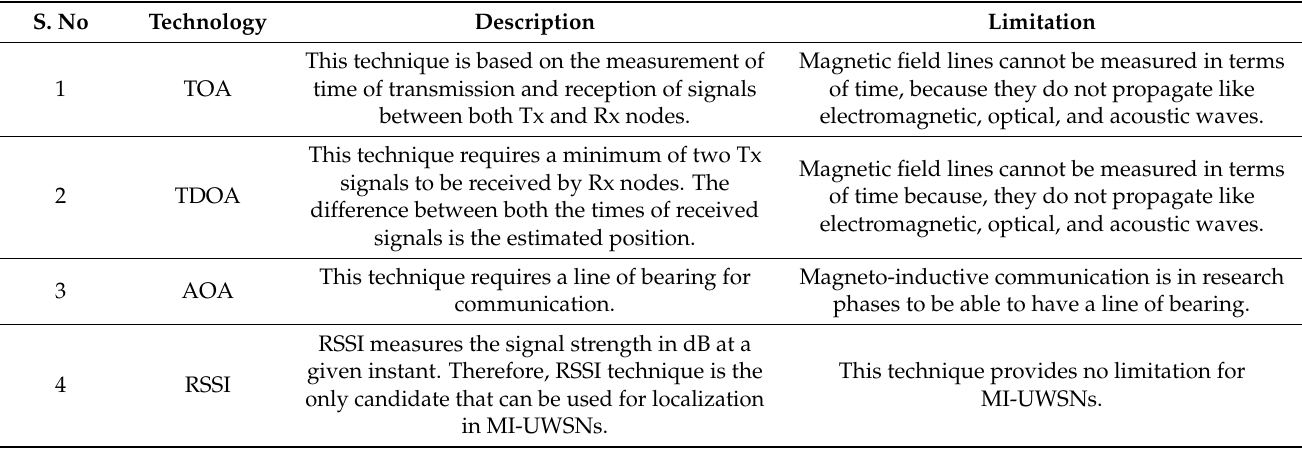
Table 1. Finding suitable localization process for MI